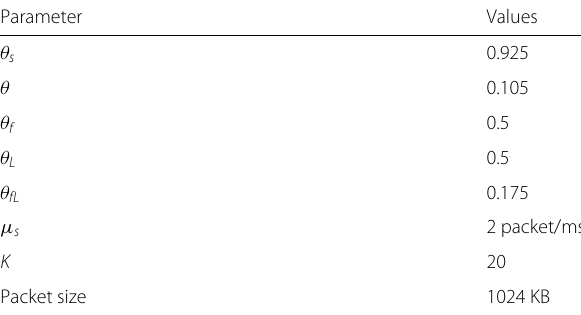
Table 1 Parameters for experimental